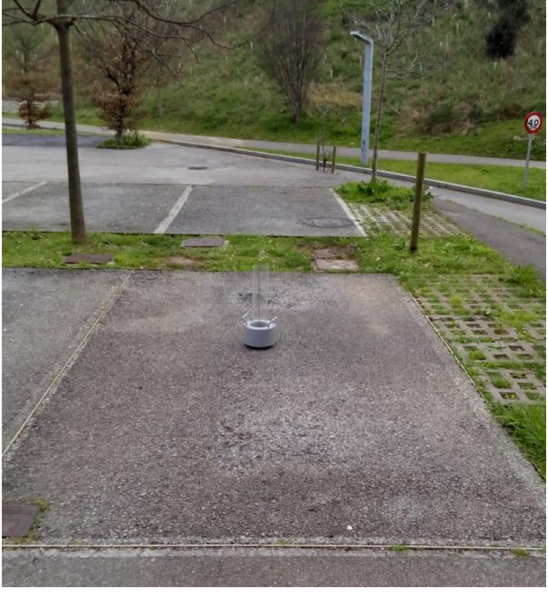
Figure 3. LCS Permeameter ready to begin the NLT-327/00 test on porous-mixture surfaces. The experimental procedure consists of the following